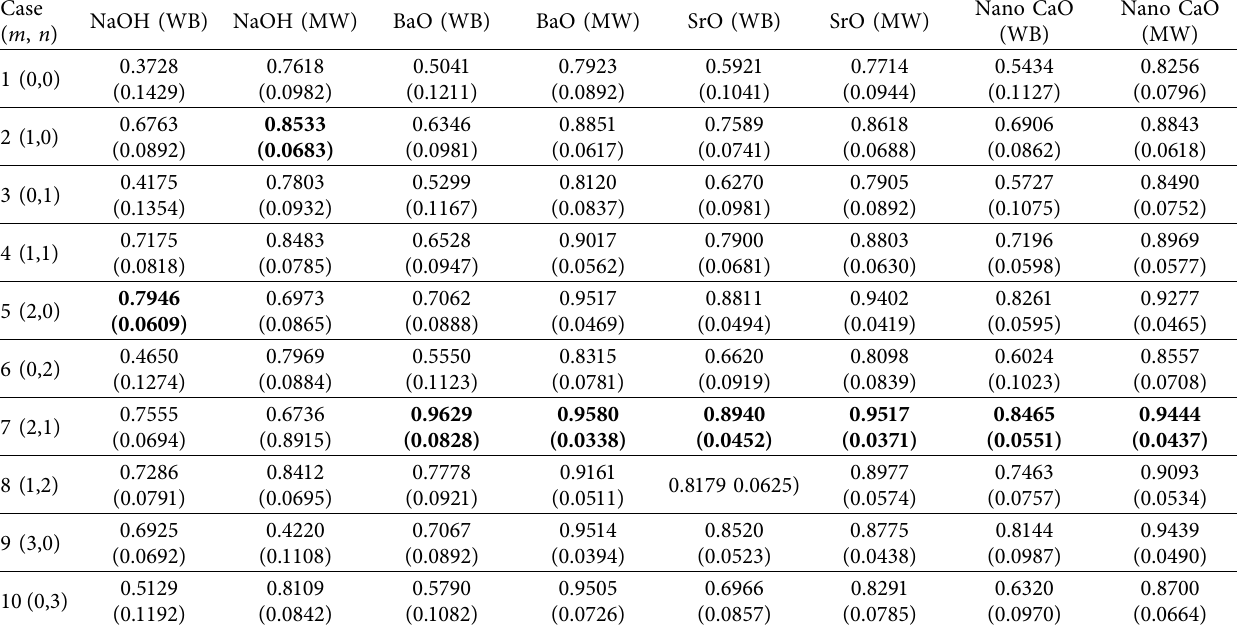
Figure 3: FAME yield as a function of time and temperature for NaOH, BaO, SrO, Nano CaO catalysts for the water bath (WB) and microwave (MW) Table 3: R 2 and NRMSD (in brackets) for various catalysts and reaction orders for WB and MW heating at 70 o C (numbers in bold refer to largest R 2 and lowest NRMSD).